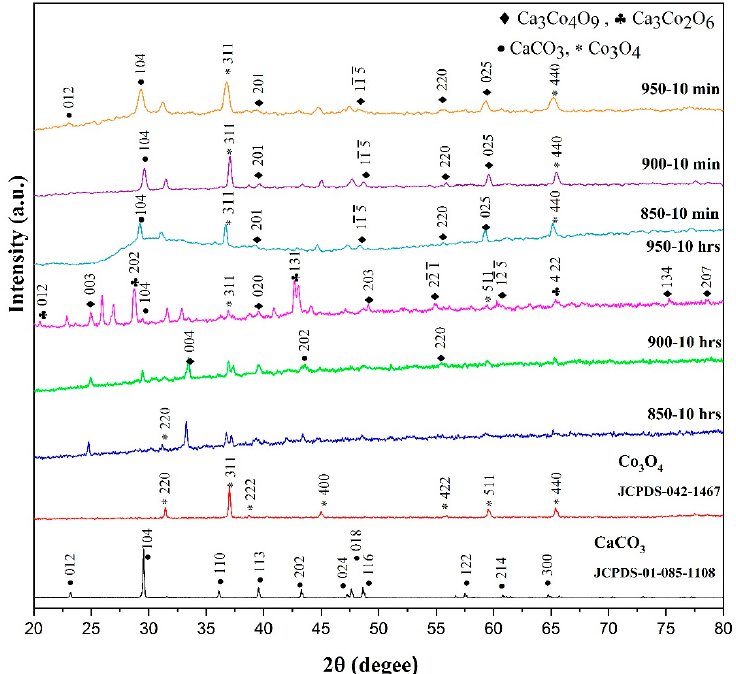
Figure 3. X-ray diffraction (XRD) patterns of bulk samples synthesized at 850, 900, and 950